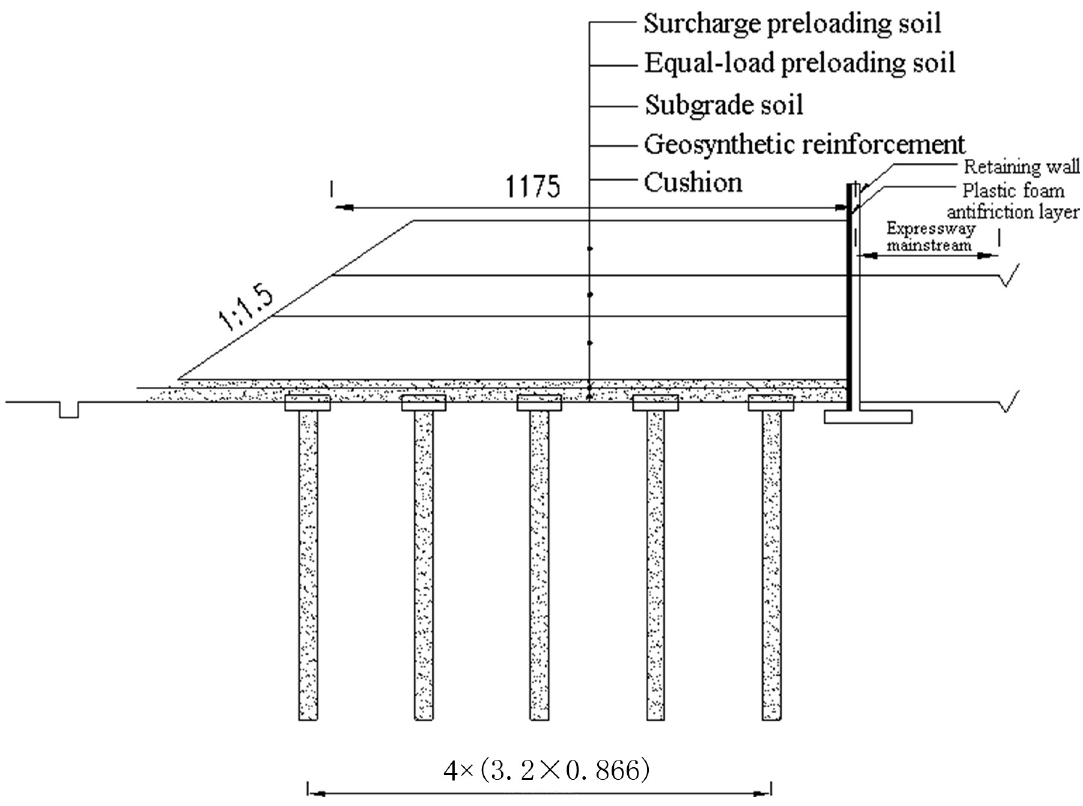
Fig 6. Embankment construction details for Section A2 of the